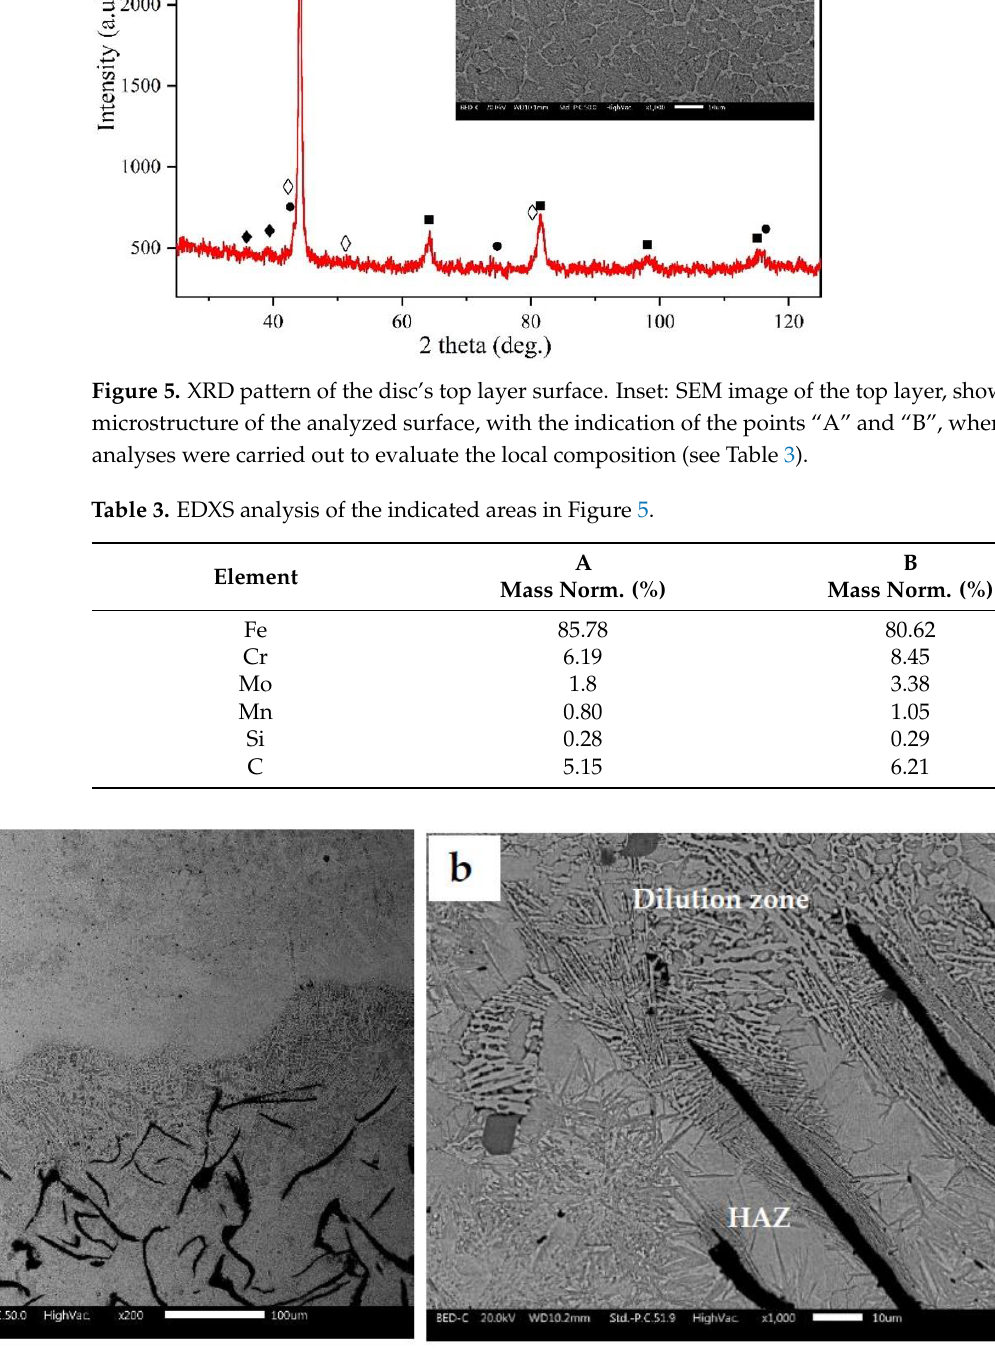
Figure 6. ( a ) GCI–buffer layer interface and ( b ) melted zone and heat-affected zone at higher magnification.